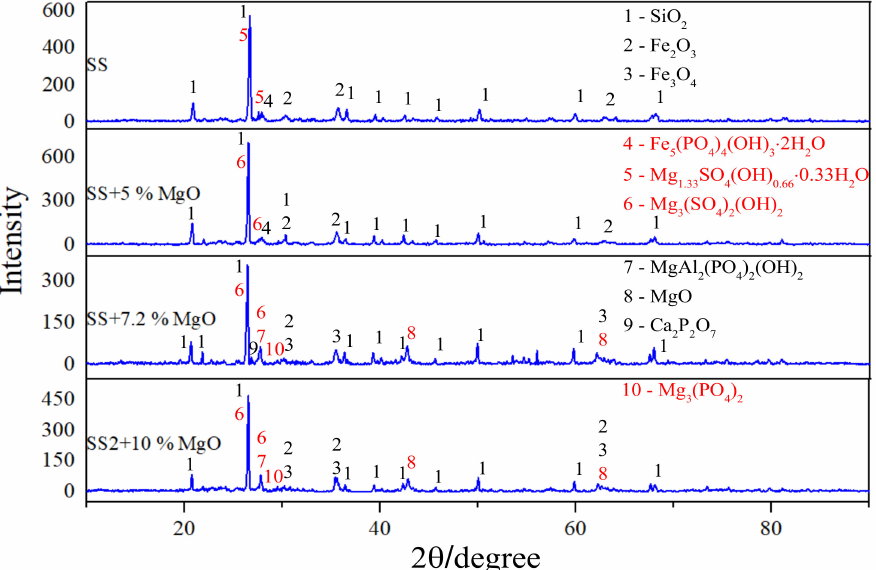
Figure 7. XRD curves of ashes collected from the combustion of SS and 0–10% MgO with 5% extra H 2 O at 900 ◦